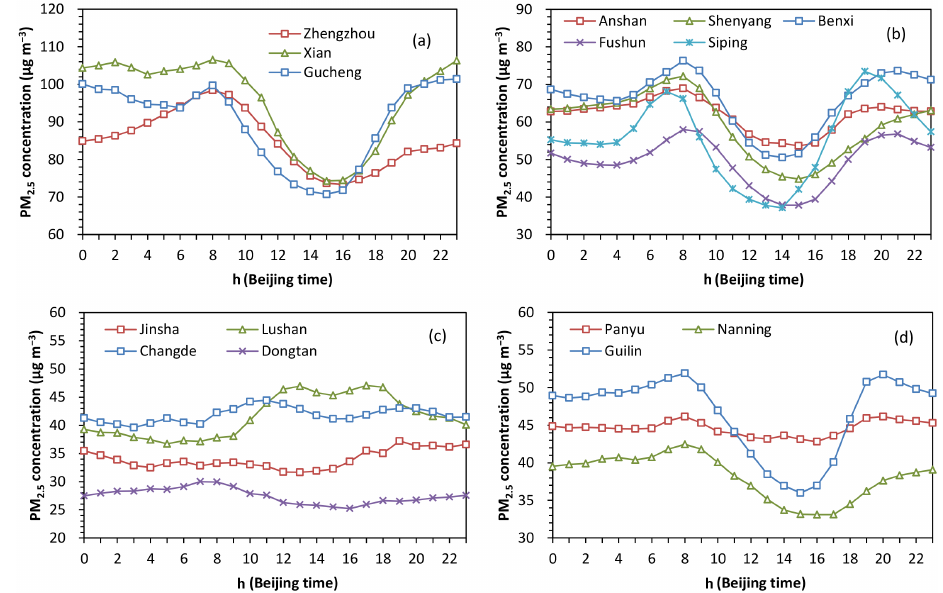
Figure 7. Diurnal variation of PM 2 . 5 concentrations at the stations (a) on the HBP and Guanzhong Plain, (b) in northeast China, (c) along the middle and lower reaches of the Yangtze River and (d) in southern China.